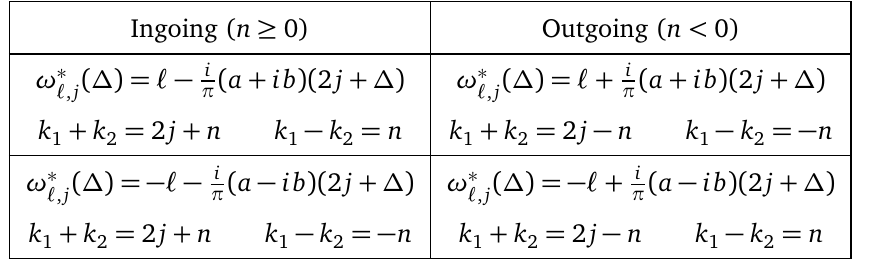
Table 2: Quasinormal modes and their associated Selberg zeta integer